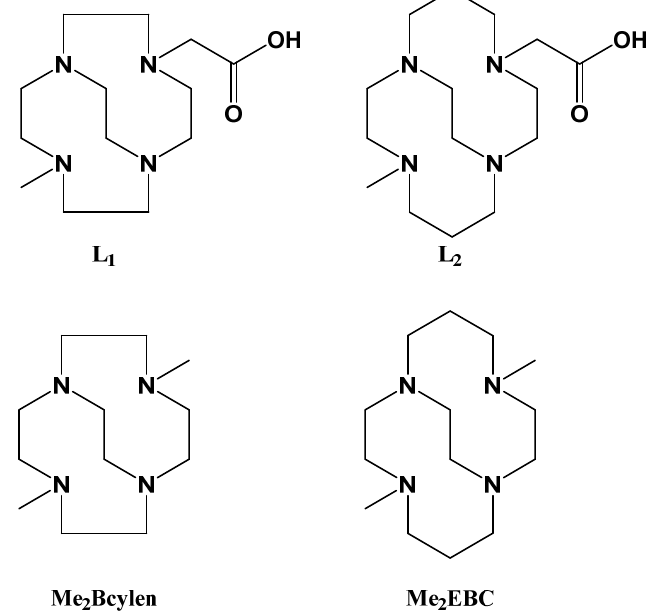
Figure 1. Ligands L 1 and L 2 , inspired by the Me 2 Bcyclen and Me 2 EBC